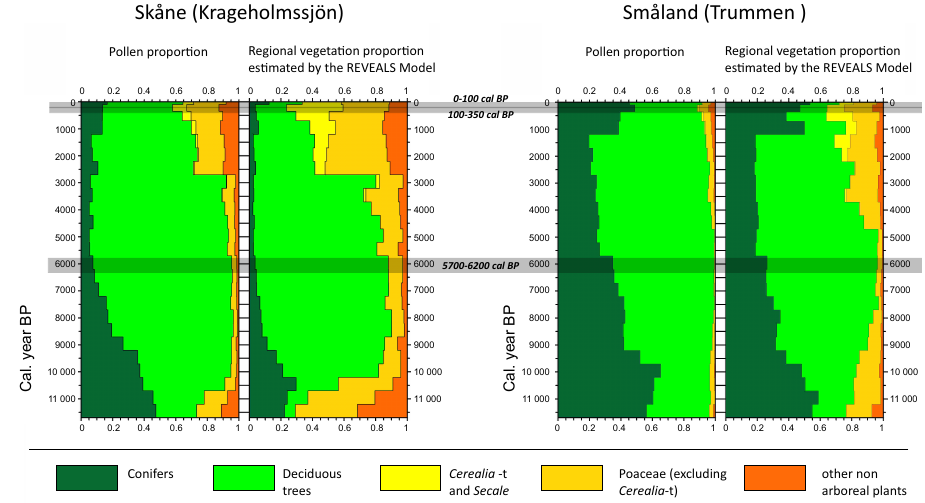
Fig. 7. REVEALS reconstructions of Holocene vegetation changes (right in each panel) in southern Sweden based on the pollen records (left in each panel) from Kragehomssj¨on (province of Sk˚ane, left) and Lake Trummen (province of Sm˚aland, right) (from Sugita et al., 2008, modified). See Fig. 8 for the locations of Sk˚ane and Sm˚aland. The selected three major time-windows studied in the LANDCLIM project are indicated. REVEALS was run with 24 pollen taxa with the pollen productivity estimates from southern Sweden (Brostr¨om et al., 2004). The taxa included in the groups “conifers”, “deciduous trees”, “Cerealia-t” (cereals, rye excluded) and “other non-arboreal plants” (herbs and shrubs) are the same as in Fig. 6. Secale =rye;